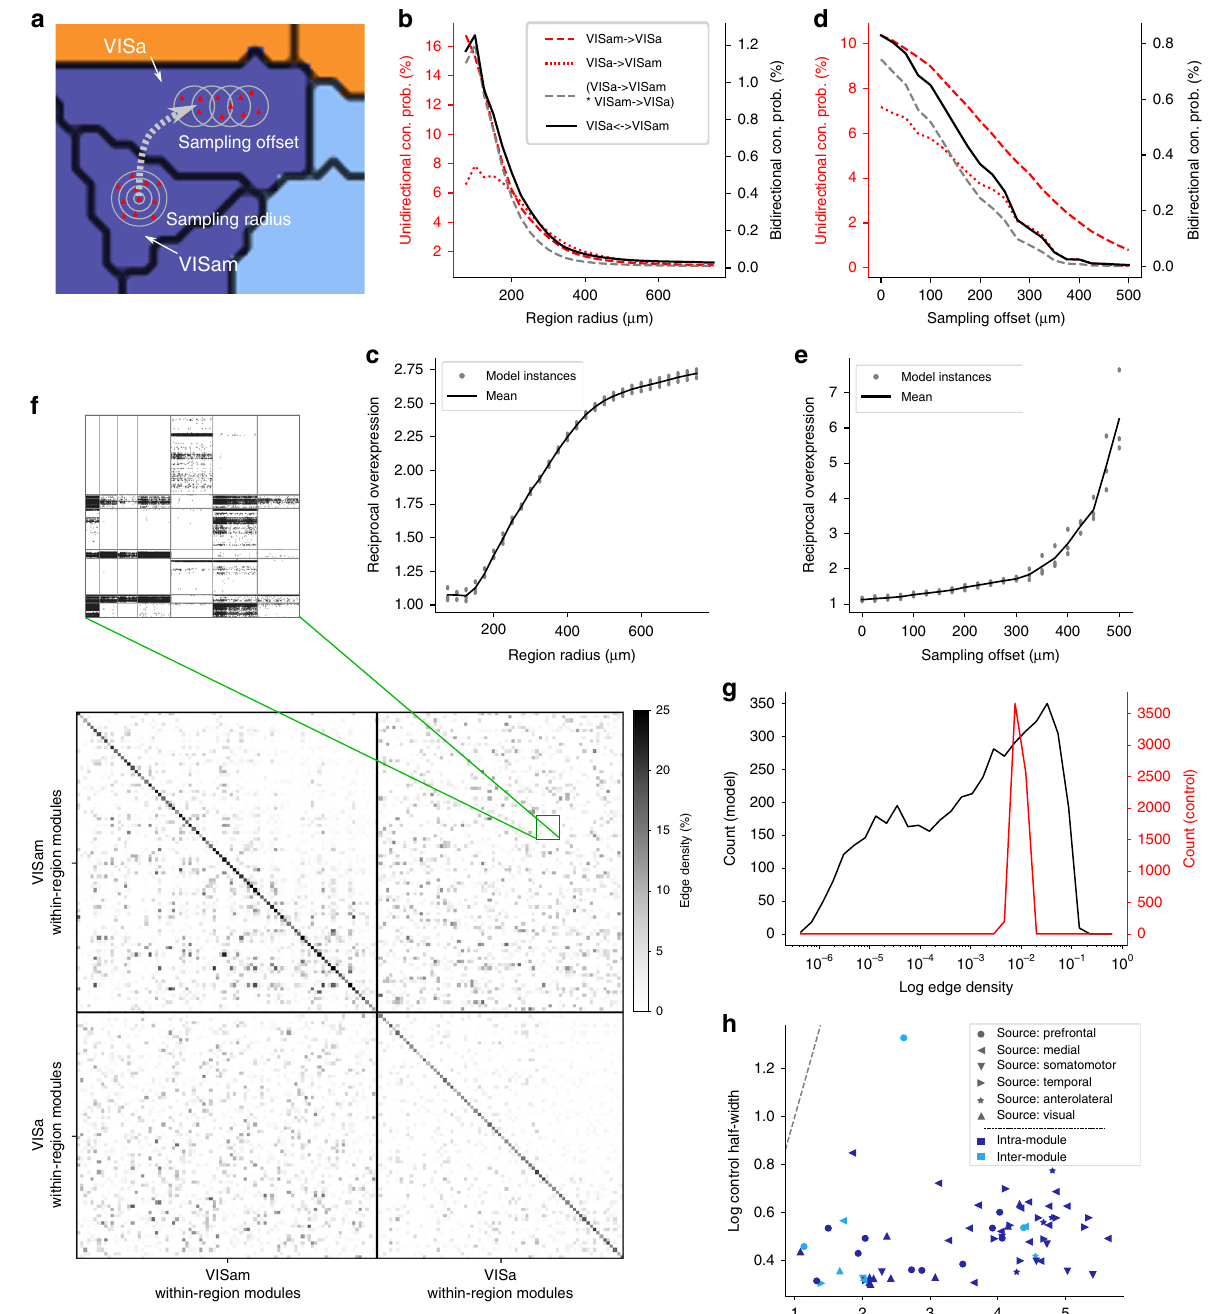
Fig. 8 Bidirectional micro-connectivity and modularity. a Connectivity between individual neurons in VISa and VISam was sampled by de fi ning a subvolume with various radii in VISam (sampling radius), then by fi nding the center of the projection from the subvolume to VISa according to the mapping (dashed arrow), moving it (sampling offset) and de fi ning a subvolume with the same radius around it. b Unidirectional (red) and reciprocal connection probabilities for various sampling radii with zero-sampling offset. Gray: expected from unidirectional connectivity; black: model. c Ratio of reciprocal connectivity measured in the model over the expected value. Gray: three instances; black: mean of n = 3 instances. d As b , but for a sampling radius of 150 μ m with various sampling offsets. e As c , but for sampling offsets. f Bottom: edge density, i.e., the number of connections over the number of pairs, of the microconnectivity between within-region modules that were de fi ned by clustering the connectivity within the two brain regions (see the Methods section). Top: neuron-to-neuron connectivity between 7 × 7 within-region modules outlined in green. Gray lines indicate boundaries between within-region modules. g Distribution of edge densities in f (top right quadrant) compared with a random control. h Width of the distribution of edge densities (as in g ) at half height, model against control, for projections with a density over 0.02 μ m − 1 . Circles: projection originating in the prefrontal module; stars: anterolateral module; left-pointing triangles: medial; downward-pointing triangles: somatomotor; right pointing: temporal; upward pointing: visual; dark blue: intramodule projection; light blue: